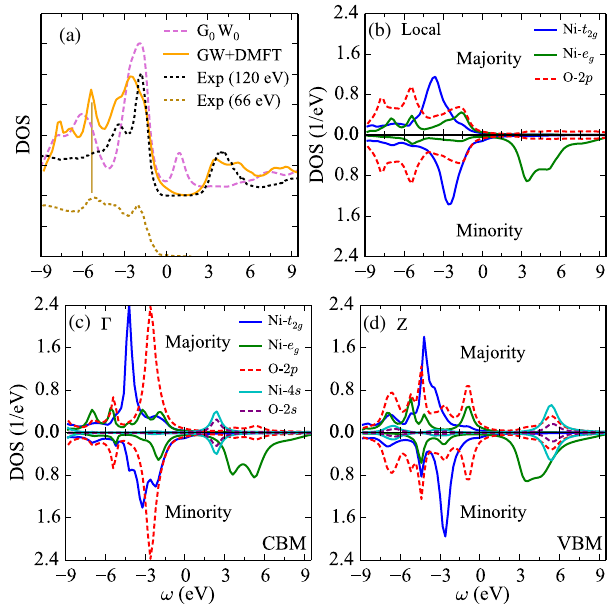
FIG. 3. Full cell GW þ DMFT results for NiO (AFM phase) based on the PBE reference. (a) Local DOS. The experimental spectra are taken from Ref. [85]. (b) Orbital-resolved local DOS. (c),(d) Orbital-resolved and momentum-resolved DOS at the Γ point (CBM) and Z ¼ ð 0 . 5 ; 0 . 5 ; 0 . 5 Þ point (VBM). A broadening factor of 0.4 eV is